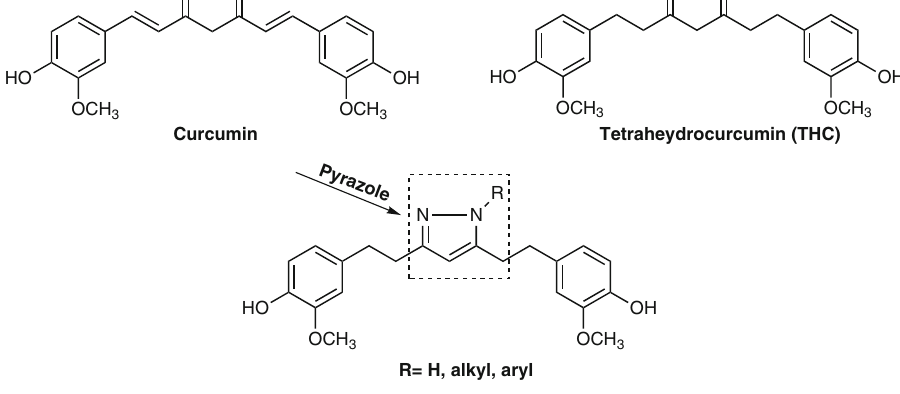
Fig. 1 Structures of curcumin, tetrahydrocurcumin (THC) and pyrazole derivatives of